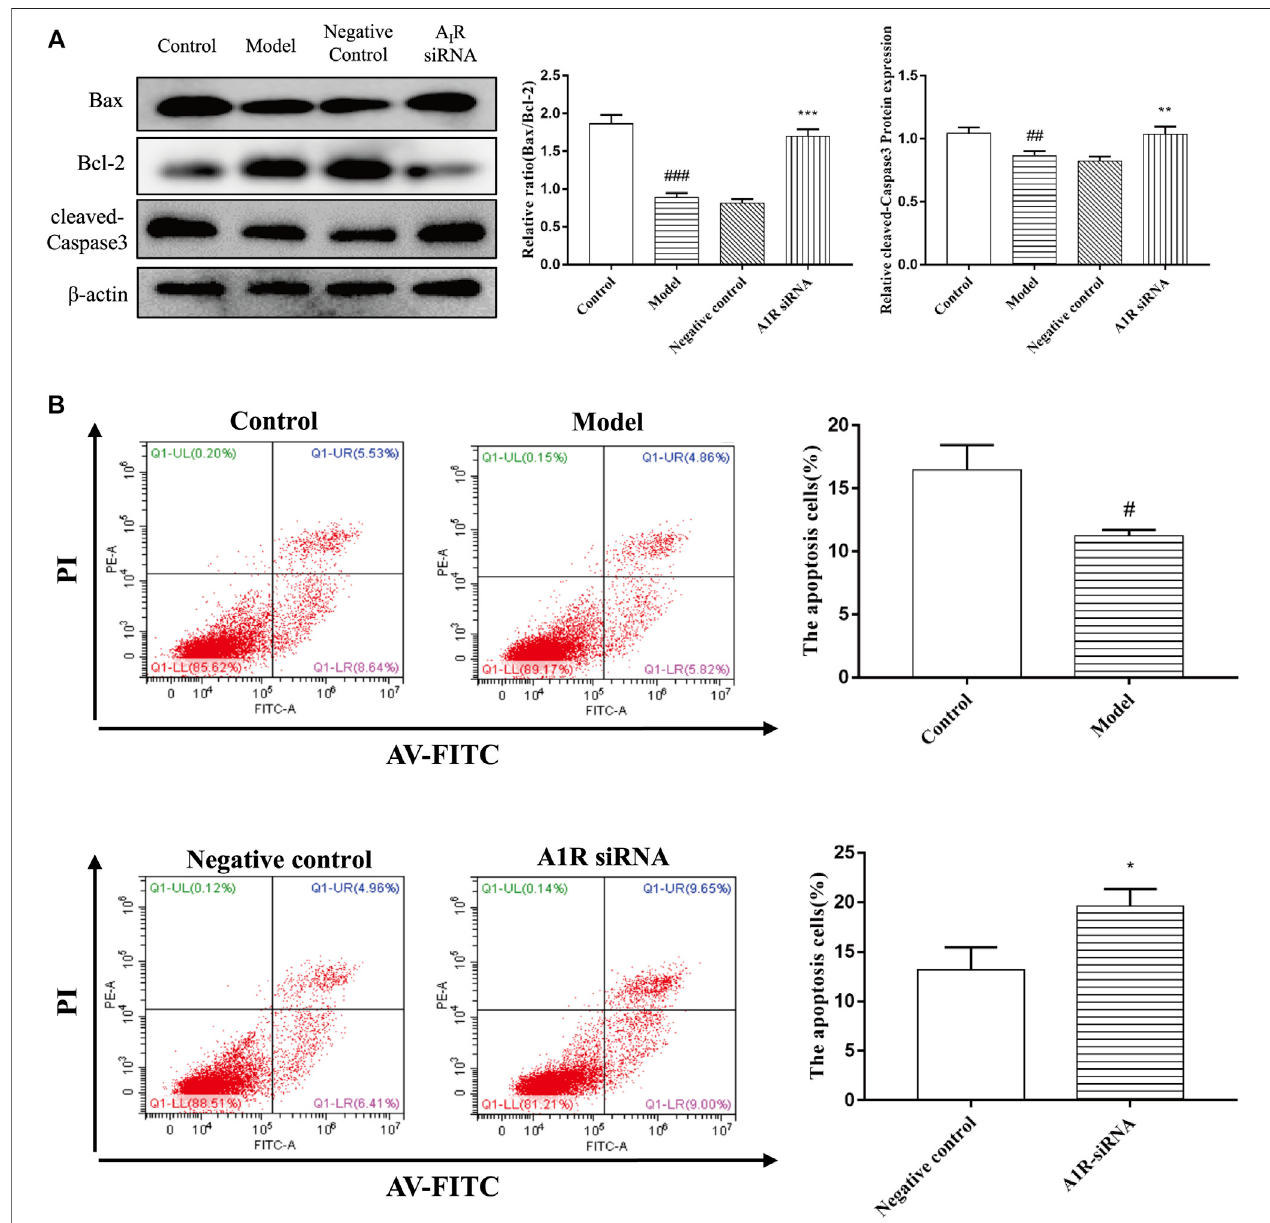
FIGURE7| EffectofsilencingA 1 Roncellapoptosisinacetaldehyde-inducedHSC-T6cell. (A) ExpressionofBax,Bcl-2,andcleavedcaspase-3inHSC-T6cell. (B) Effect of silencing A 1 R on the apoptosis of acetaldehyde-induced HSC-T6 cell was determined by fl ow cytometry. # p < 0.05, ## p < 0.01, ### p < 0.001 vs. the control group. *p < 0.05, **p < 0.01, ***p < 0.001 vs. the negative control